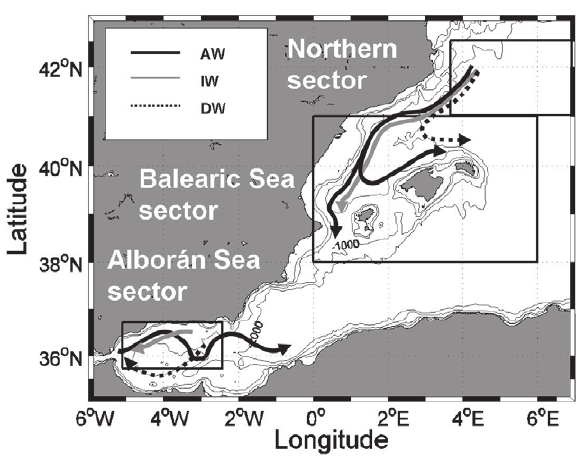
Fig . 1. – squares are the three areas where temperature and salin- ity profiles have been obtained from MeDaTlas/2002 data base. The black line depicts the main paths followed by atlantic Waters (aW). The grey line is the path followed by intermediate Waters, which can be liW or WiW. The black dotted line is the path fol- lowed by deep waters. We have indicated only Deep Water (DW) because according to Millot et al. (2006) this could be at present a mixture of WMDW and